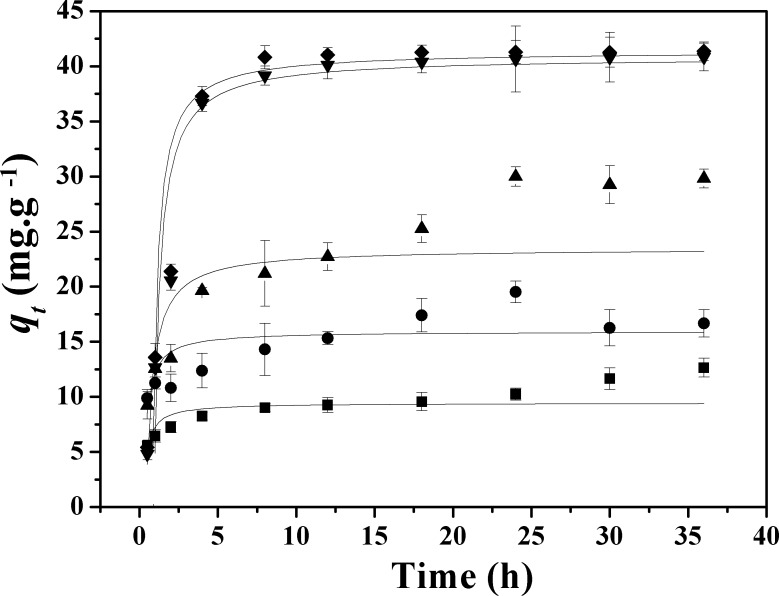
Effect of contact time on Co2+ adsorption by Ca-Mt and APTES-Mts: (■) Ca-Mt, (●) APTES1.0CEC-Mt, (▲) APTES2.0CEC-Mt, (▼) APTES3.0CEC- Mt, (◆) APTES4.0CEC-Mt.